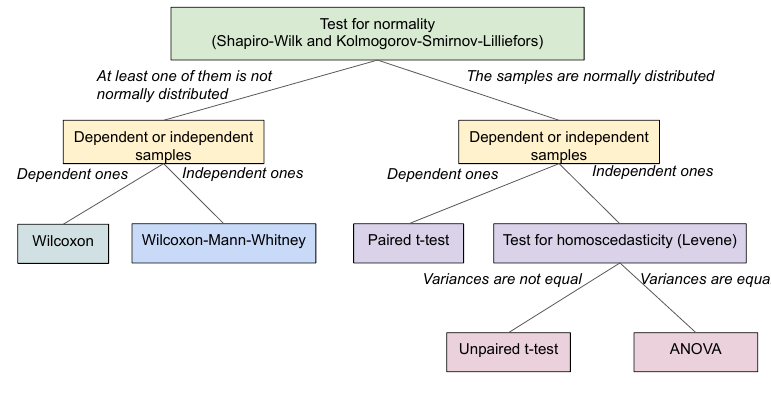
Figure 7. Statistical significance